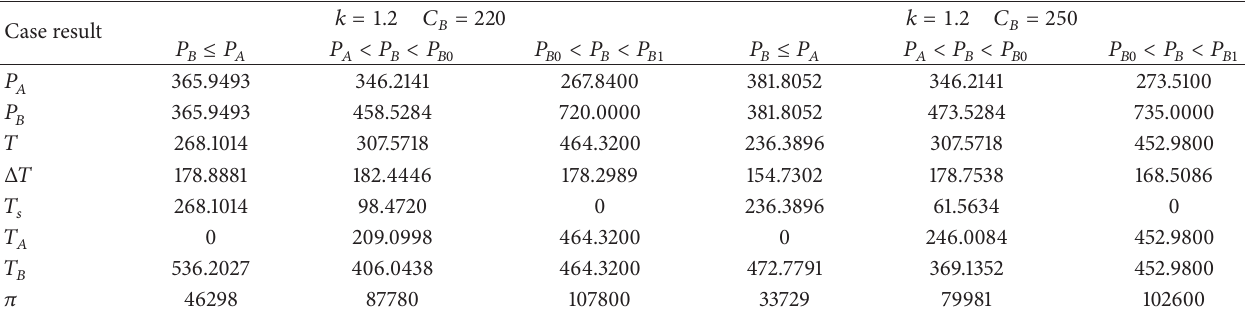
Table 4: The effect of RP cost changing in Stackelberg-merger model ( 𝑘 = 1.2 ).